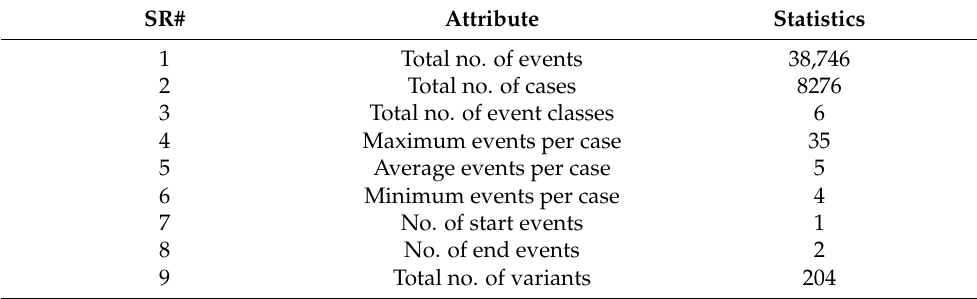
Table 5. Statistics of log data after removing incomplete traces.